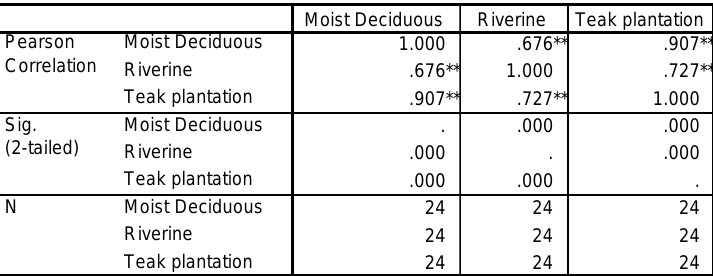
Correlation Among the Insect Abundance in Different Habitats